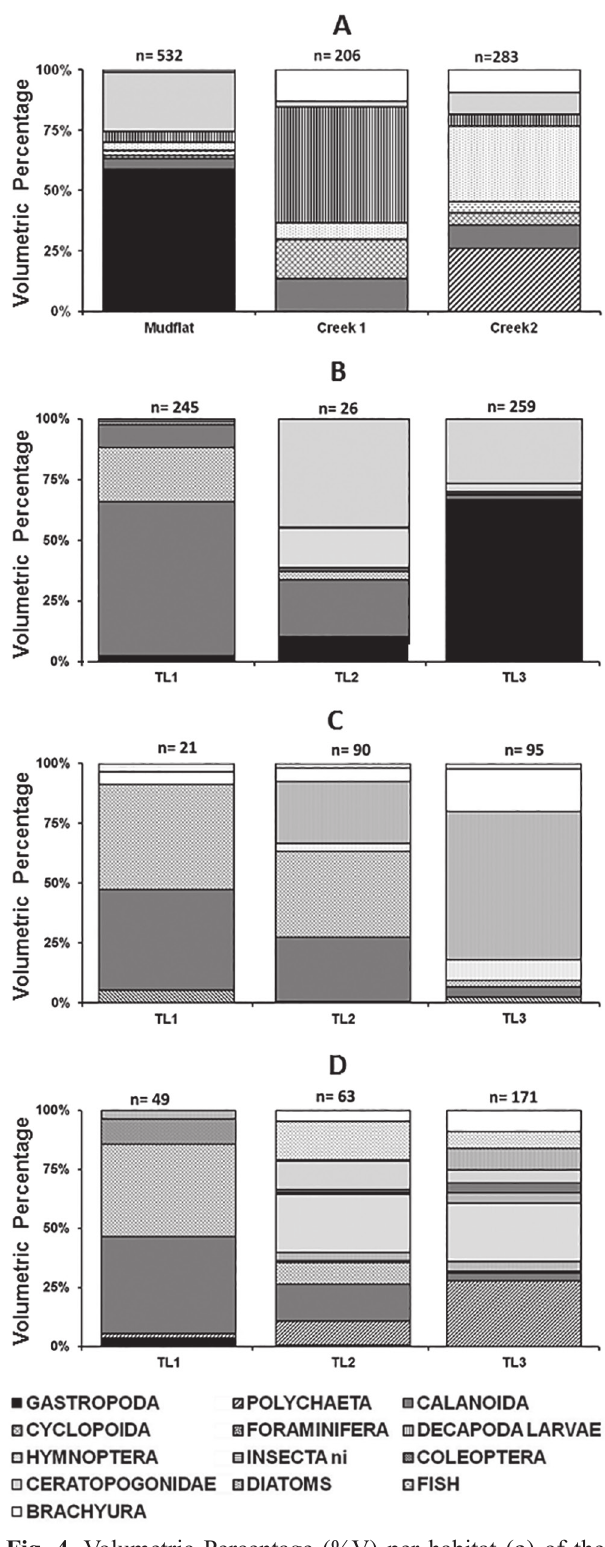
Fig. 3. Size distributions of Atherinella brasiliensis at sampling areas (Mudflat, Tidal Creek 1 and Tidal Creek 2) in de Mamanguape estuary river. Number of individuals (n) is listed. Age Class: White bar= small juveniles; Light Gray bar= juveniles, and Dark Gray